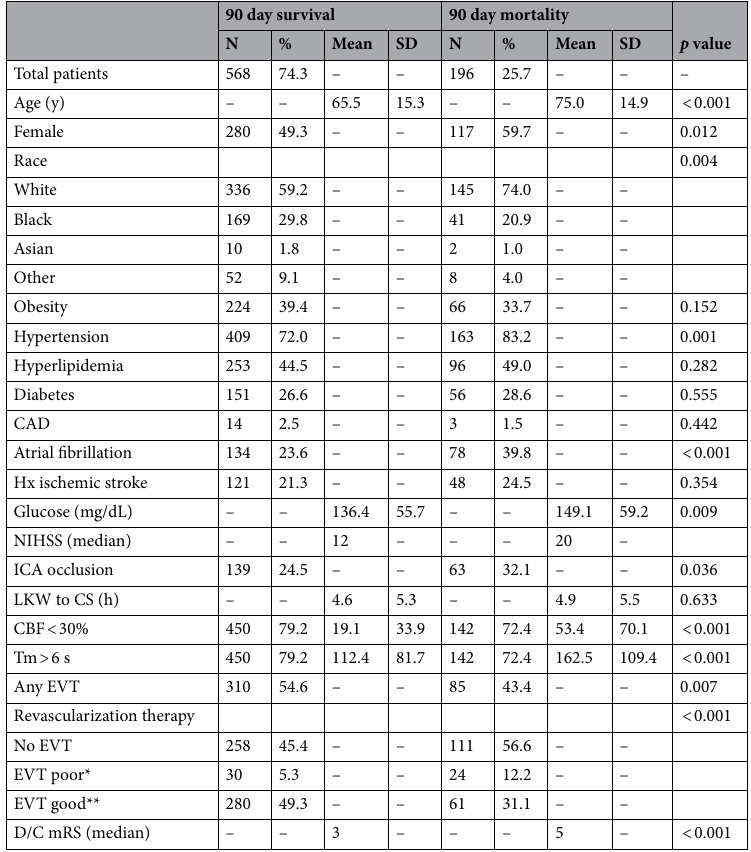
Table 3. Univariate analysis: 90-day mortality. SD Standard deviation, Hx History, CAD Coronary artery disease, NIHSS National Institute of Health Stroke Scale, ICA Internal carotid artery, LKW Last known well time, CS Code stroke, CBF Cerebral blood flow, Tm > 6 s Time to maximum greater than 6 s, EVT Endovascular therapy, D/C Discharge, mRS Modified Rankin scale score. Percentages listed are with respect to subjects in individual ‘90 day survival’ or ‘90 day mortality’ groups, except for Total Patients. *EVT poor = EVT with thrombolysis in cerebral infarction score 0–2a. **EVT good = EVT with thrombolysis in cerebral infarction score 2b–3.